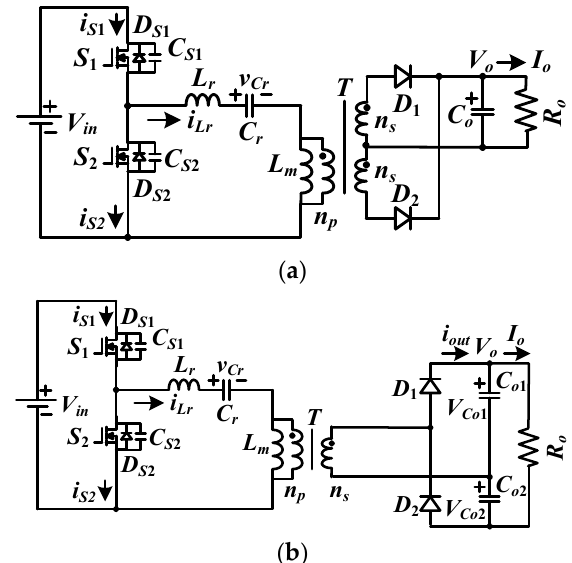
Figure 1. Conventional inductor–inductor–capacitor (LLC) converter based on ( a ) a center-tapped rectifier structure and ( b ) a voltage double rectifier structure.